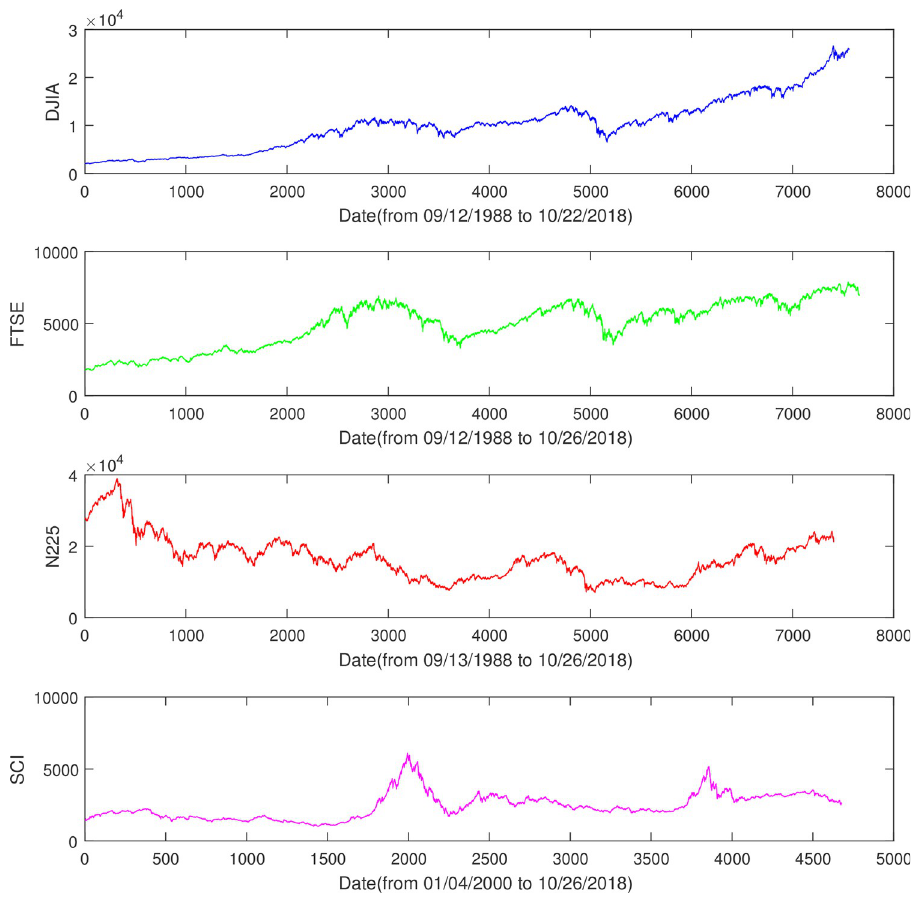
Fig 2. Temporal price movement of four stock indices. From top to bottom, DJIA, FTSE, N225 and SCI